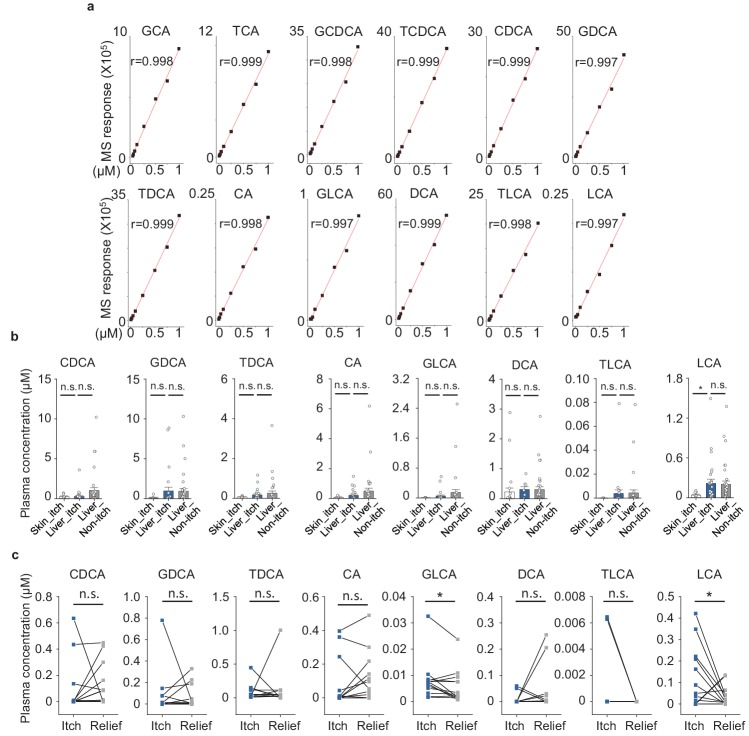
Quantification of bile acids in human plasma.(a) Standard curve of 12 bile acids quantified by HPLC-MS/MS. All the 12 bile acids show good linear correlation between the MS response and the concentration (0.1–1 μM). (b) Quantification results of 8 bile acids shown in Figure 7a. (c) Quantification results of 8 bile acids shown in Figure 7c. All error bars represent the s.e.m.. Student’s t-test, *p<0.05, and n.s. not significant (p>0.05).